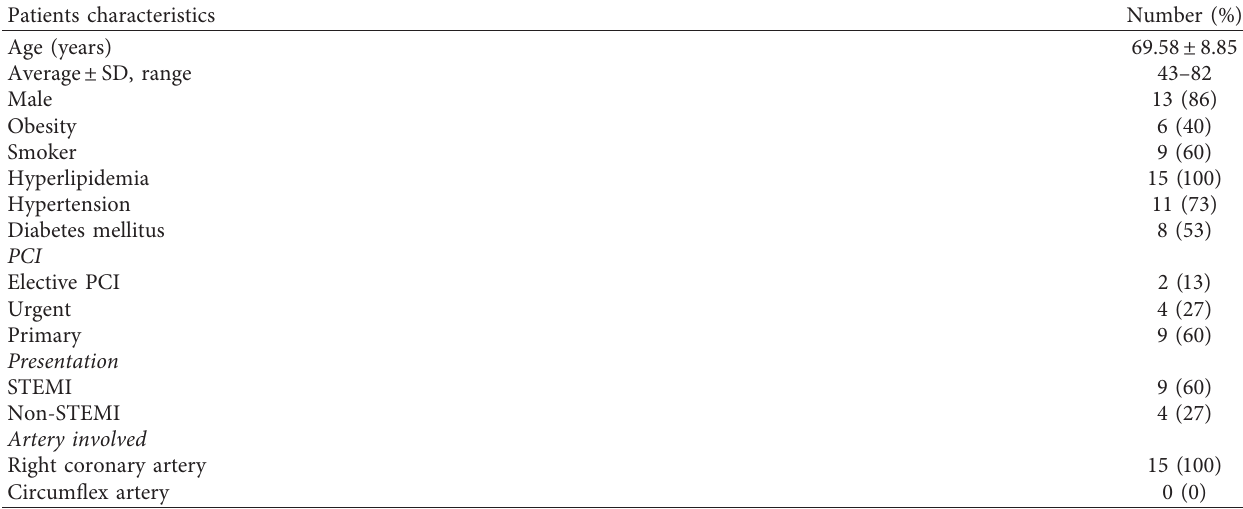
Table 2: Patient